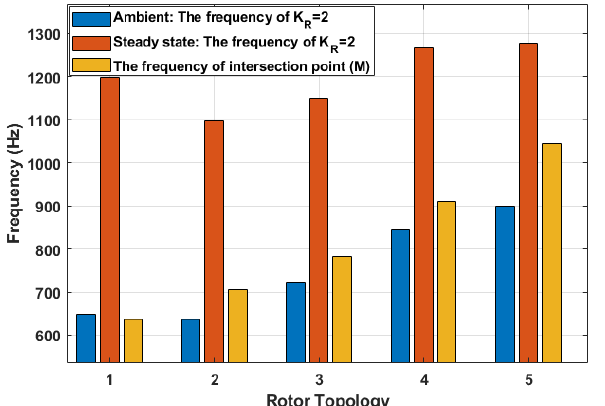
Figure 13. Comparison among the five considered topologies in terms of: (1) the frequency at which k R = 2 at ambient temperature (in blue), (2) the frequency at which k R = 2 at steady-state temperature (in red), and (3) the frequency intersection point where the total ohmic losses at steady-state temperature become lower than those at ambient temperature (in yellow).